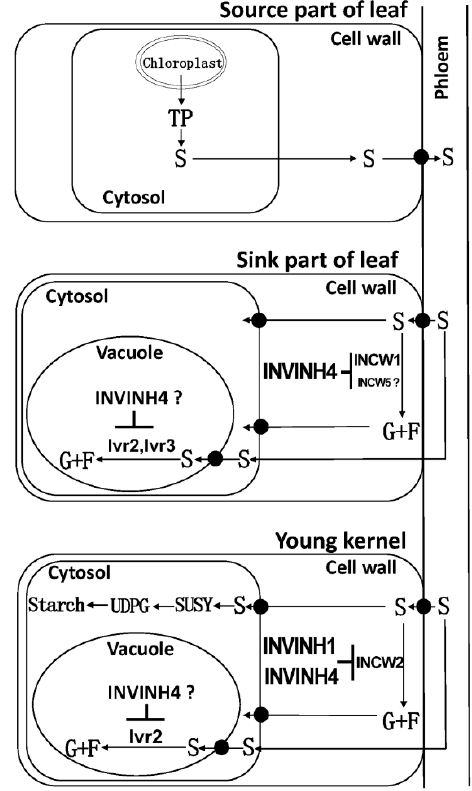
Figure 14. A model explaining the influence of Zm-INVINH4-involved invertase-mediated sucrose degradation from the source to sink in maize. Sucrose (S); fructose (F); glucose (G); cell wall invertase (INCW); vacuolar invertase (Ivr); invertase inhibitor (INVINH); chloroplast-derived triosephosphate (TP); uridine diphosphate glucose (UDPG); sucrose synthase (SUSY). “ ┴ ” means inhibition.